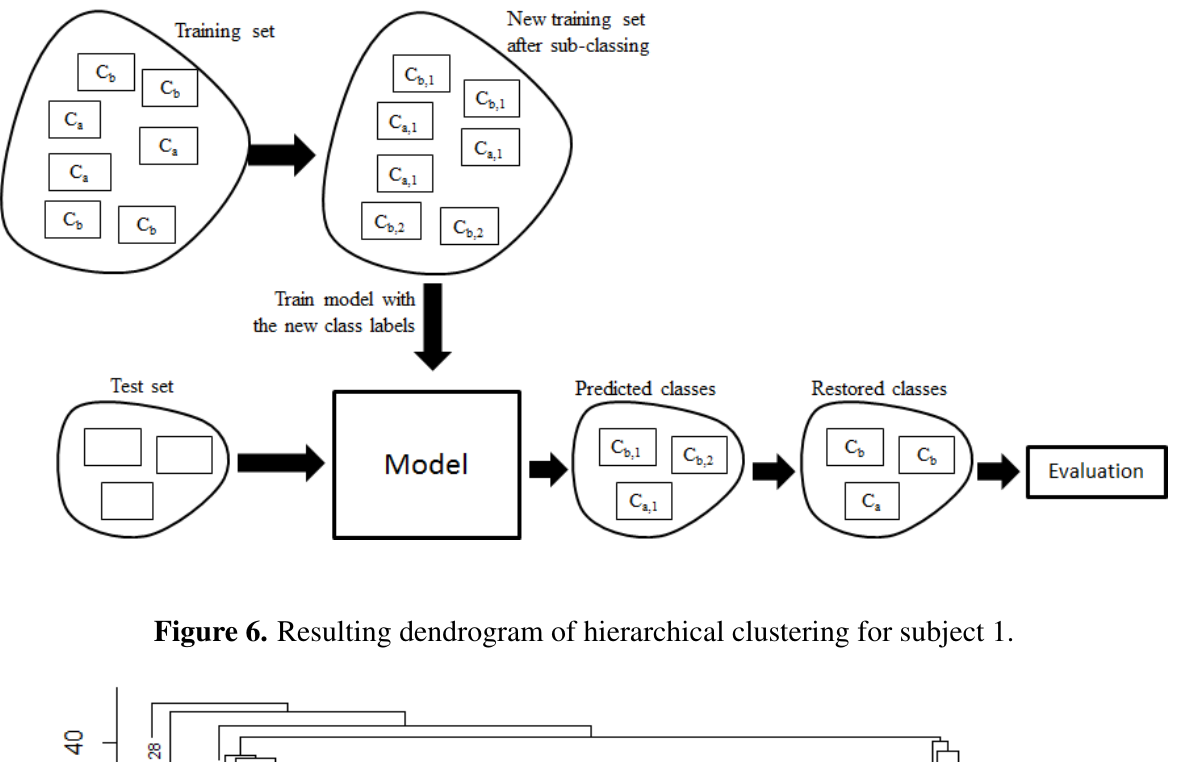
Figure 5. Overall process for performing the subclassing.